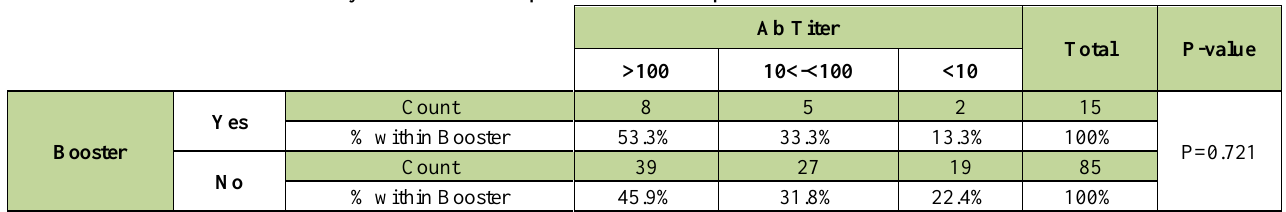
Table 12. Analysis of the relationship between the anti-hepatitis B titration and the reminder dose.